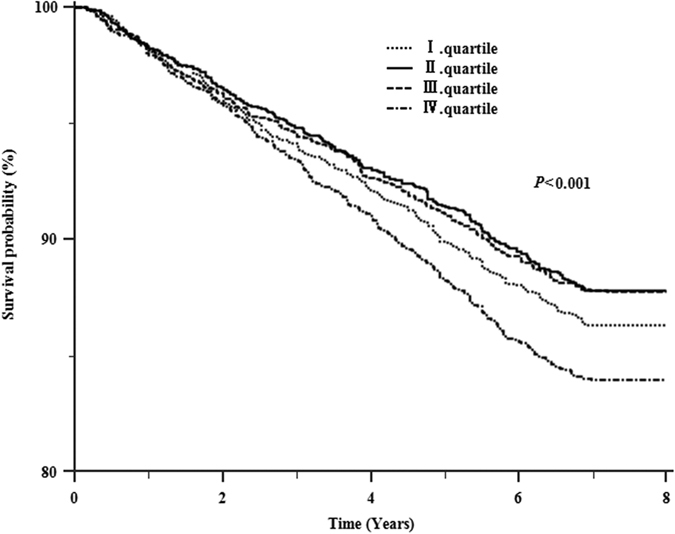
Kaplan-Meier estimates of survival probability in 8871 type 2 diabetes patients from 1 January 2007 through 31 December 2014.Patients were grouped by quartiles of the CV of FPG within the first one year of following-up. The log-rank tests revealed significant differences in survival among quartiles of the CV of FPG (P < 0.001).